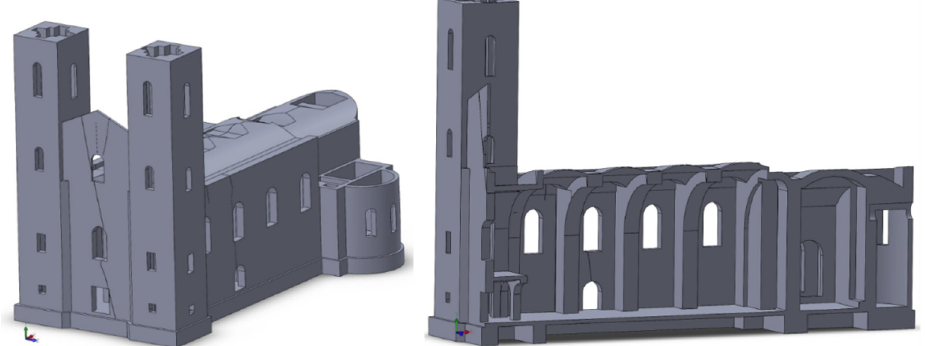
Figure 11. 3D model of the Cathedral—general shape of the model.